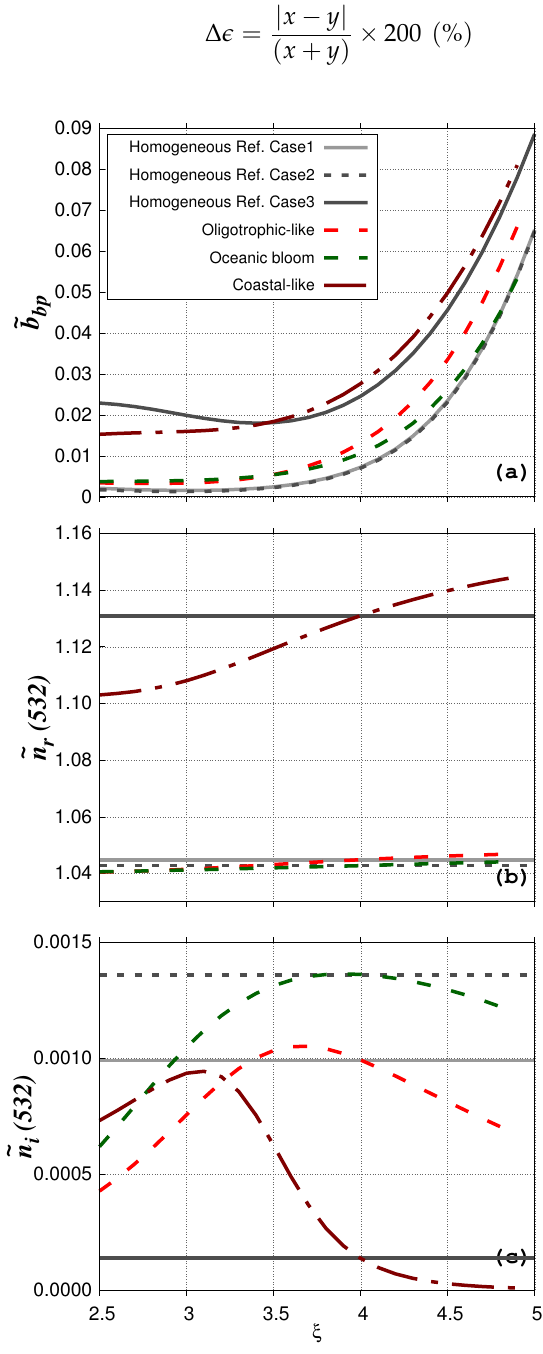
Figure 5. ( a ) Particulate backscattering ratio (cid:102) b θ a as a function of the hyperbolic slope for the oligotrophic-like bp (red dashed line), phytoplankton bloom (green dashed line), and coastal-like (brown dashed line) water bodies as described in Section 4. Black and gray lines are for homogeneous reference cases. The gray solid line corresponds to n r = 1.045, n i = 9.93 × 10 − 4 , the black dashed line to n r = 1.1043, n i = 1.36 × 10 − 3 , and the black solid line to n r = 1.131, n i = 1.37 × 10 − 4 , respectively. Phytoplankton cells are modeled as two-layered spheres with a relative volume of the cytoplasm of 20% (%cyt-%chl = 80–20). ( b ) as in panel ( a ) but for the real refractive index. ( c ) as in panel ( a ) but for the imaginary part of the refractive